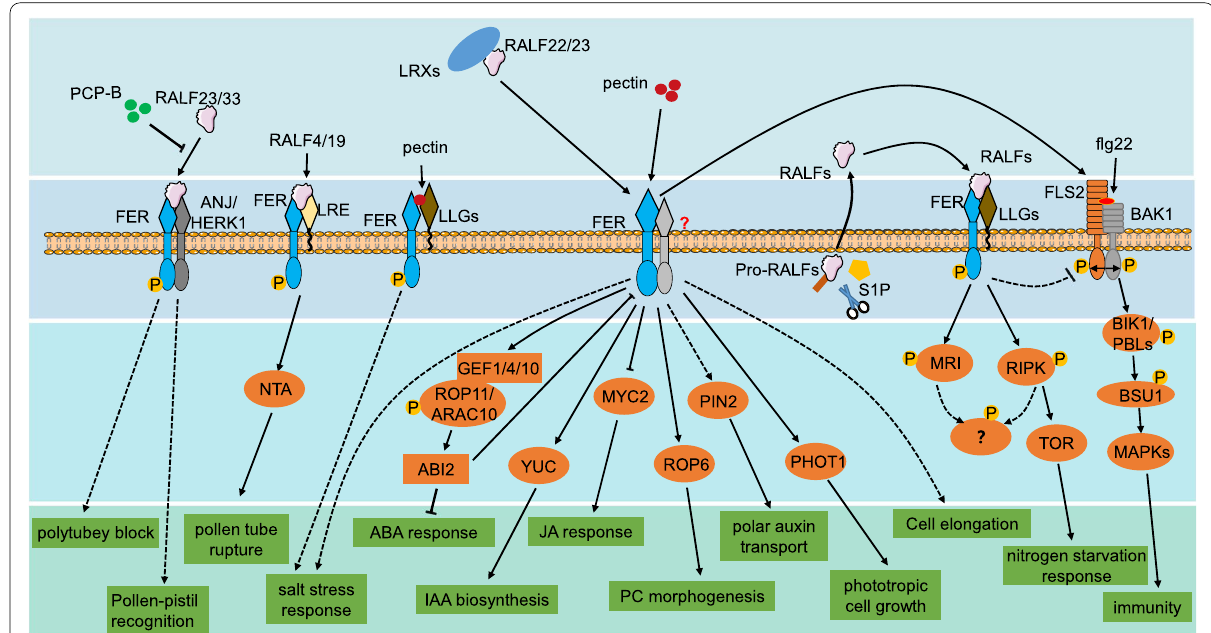
Fig. 1 Model of FER signaling pathways. The FER signaling pathway could be modulated by a 4-layers mechanism. Firstly, the extracellular ligands (RALFs, pectin and PCP-Bs) and ligand combinations (LRXs) could trigger relatively specific FER signal activation. PCP-Bs compete with RALF23/33 to deactivate FER regulated polytubey block and pollen-pistil recognition. RALF4/19 and pectin activate FER mediated pollen tube rupture and salt stress response, respectively. RALF22/23 prefer to interact with cell wall-associated LRXs at acidic pH, and RALF22/23-LRXs complex could be disassociated under salt stress or alkaline conditions to release RALF22/23 and activate FER signaling pathway. Secondly, the diverse co-receptors(ANJ/HERK1, LRE and LLGs) provide diverse perception and responses mode for FER. FER forms a complex with ANJ/HERK1 to sense PCP-Bs and RALF23/33 signals. The FER-RALF4/19-LRE complex was formed upon recognizing RALF4/19 ligands. Moreover, FER form complexes with LLGs to sense pectin and RALFs. The third FER signaling modification layer was compromised of downstream components of FER. NTA, YUC, MYC2, ROP6, PIN2 and PHOT1 are downstream components for FER, which mediate FER regulated pollen tube rupture, IAA biosynthesis, JA response, PC morphogenesis, polar auxin transport and phototropic cell growth, respectively. The FER downstream GEF1/4/10-ROP11-ABI2 pathway was also revealed to regulate ABA response. MRI and RIPK are two RLCKs downstream of FER and RIPK directly interact with TOR to regulate FER related nitrogen starvation response. However, more RLCKs downstream of FER and more pathways downstream of the RLCKs remain to